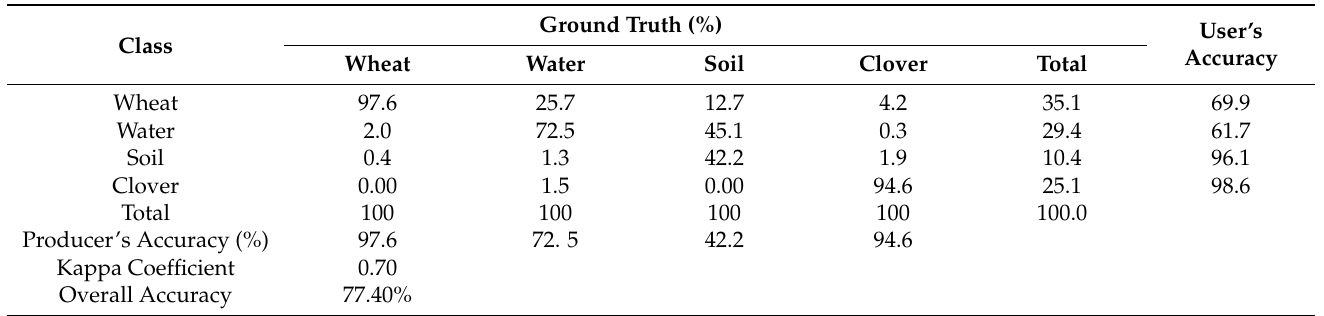
Table 5. Outputs of confusion matrix extracted for the k-means classifier of wheat and other classes in the study area South-West Nile Delta,